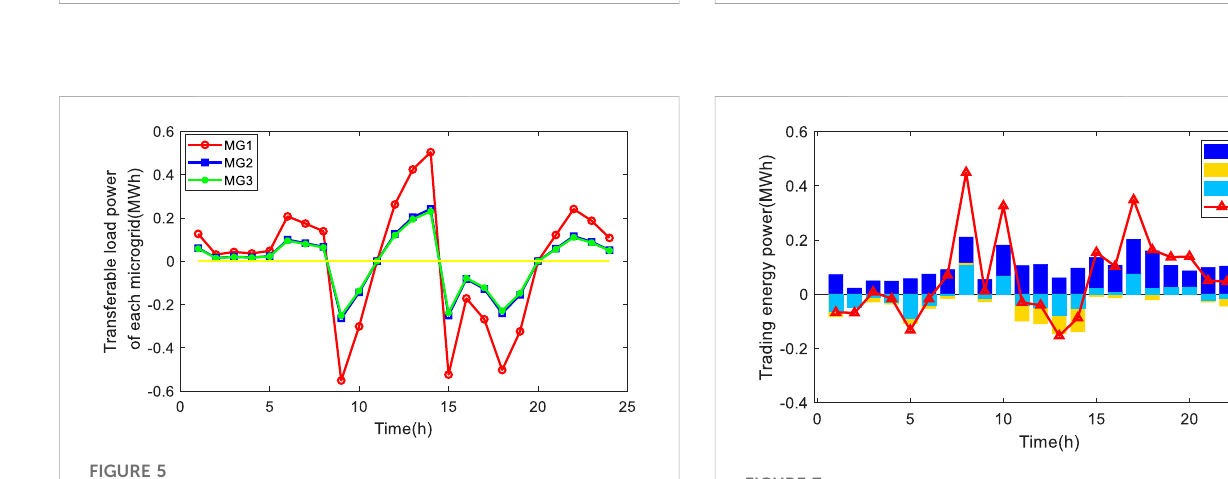
FIGURE 7 Transaction volume of each market